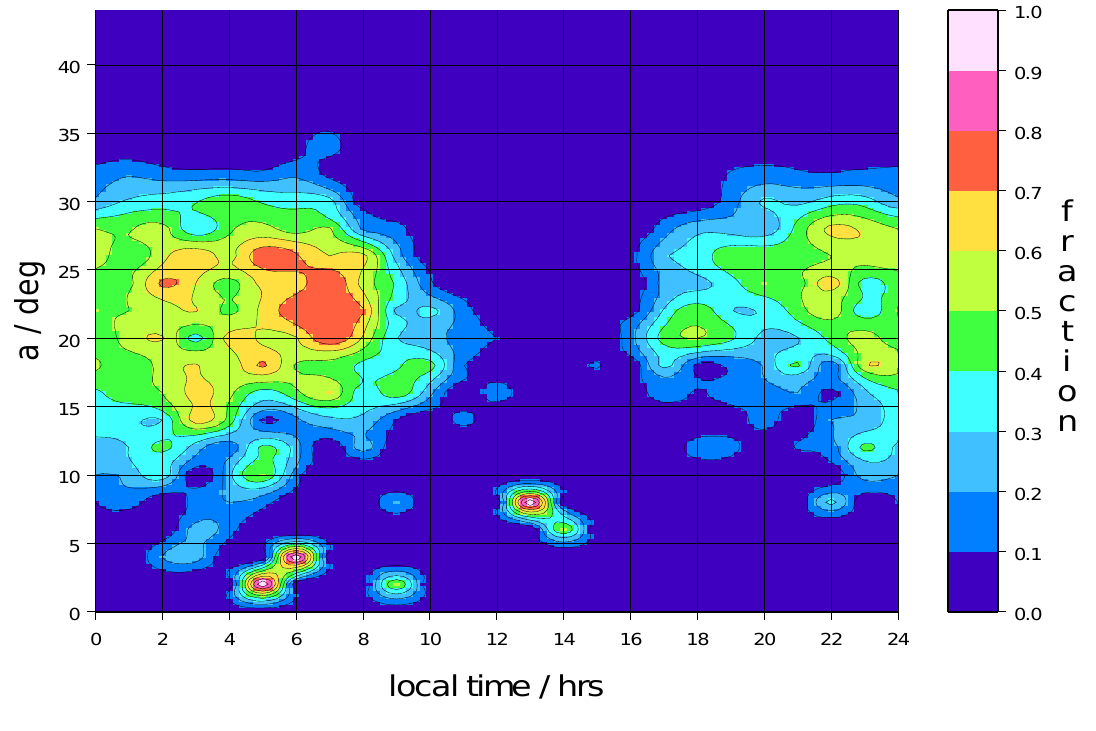
Fig. 6. Density distribution of Formosat-3/COSMIC profiles which statisfy the ELDI condition for disturbed geomagnetic conditions, A p > 10. The single patches at local noon and 5 ◦ <a< 10 ◦ are due to enhanced day side particle precipitation during the proton events of December